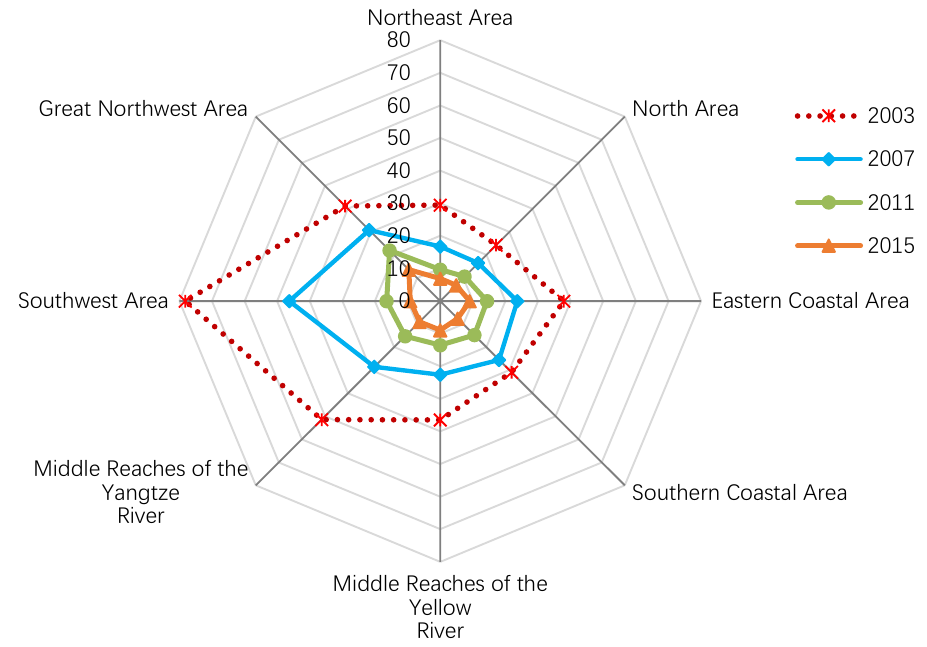
Figure 3. Regional contrast of the change in industrial wastewater emission intensity, 2003–2015. Data resources: Annual Statistic Report on Environment in China [16].